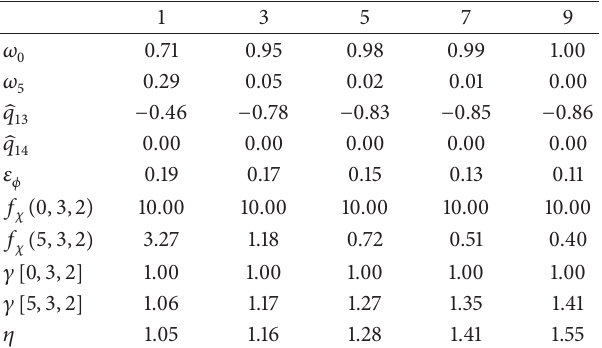
Table 2: Effects of prediction and evolution.